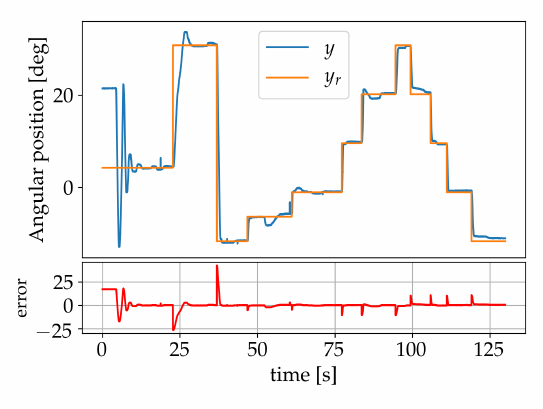
Figure 11. Learning session using set-points.